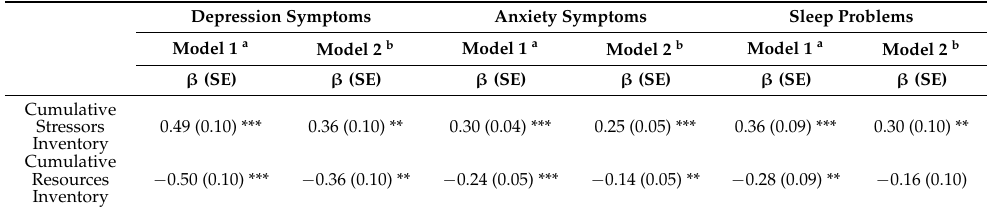
Table 6. Adjusted linear regression models to estimate associations between stressors and resources inventories and caregiver outcomes, included separately and together (n = 169) 1